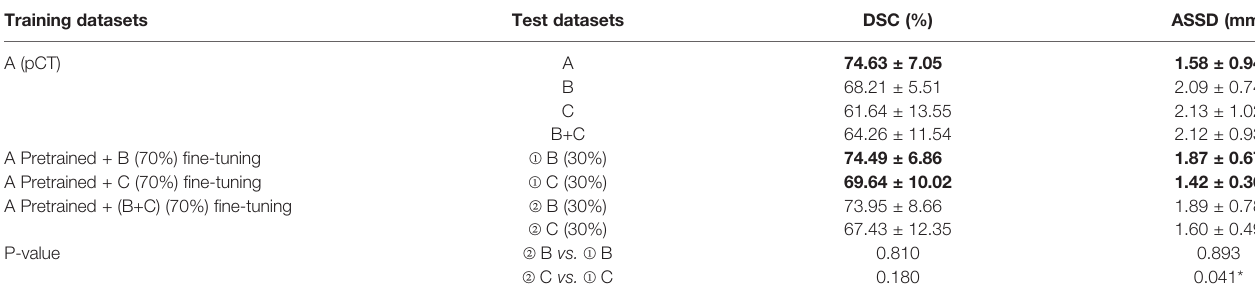
TABLE 4 | The segmentation results of the models pretrained, fi ne-tuned and validated on the dataset A, B, C and B+C. Training datasets Test